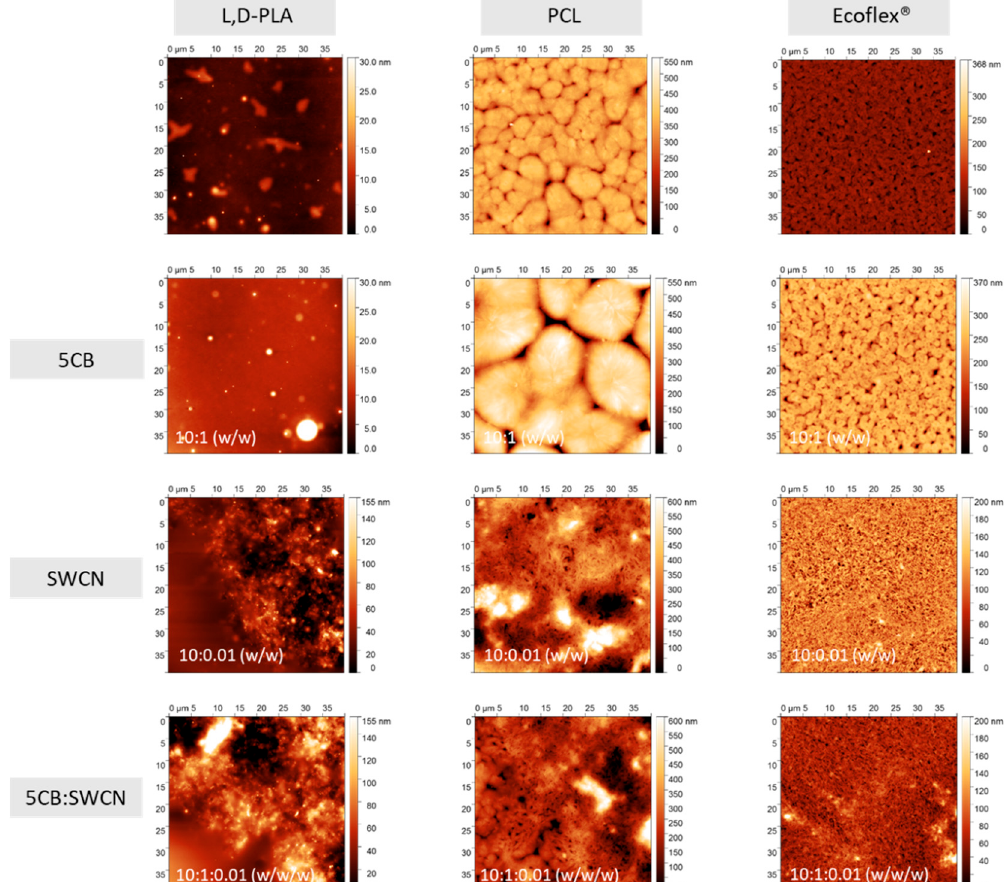
Figure 3. Atomic force microscopy (AFM) images of the pure studied polymers, binary, and ternary hybrid layers.